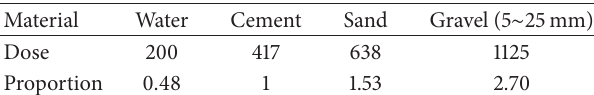
Table 2: Design of concrete mix proportion (kg/m 3